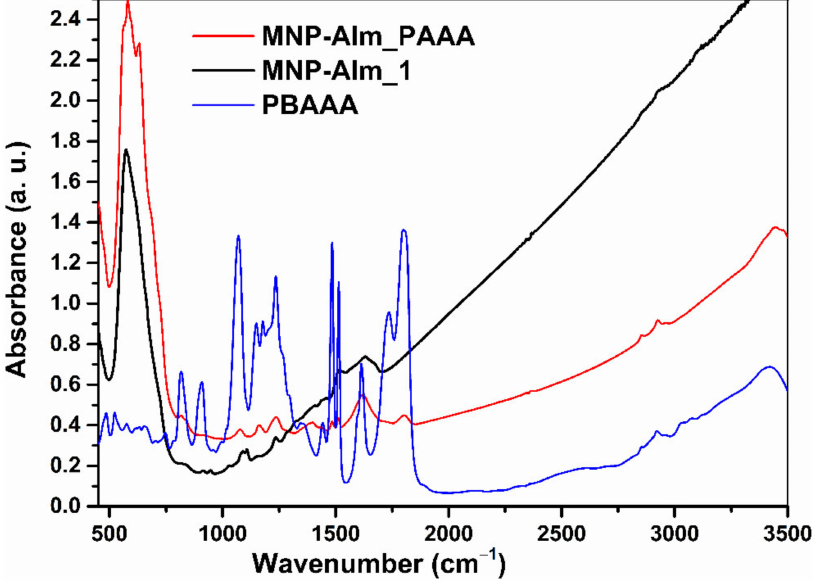
Figure 2. FTIR spectra of functionalized magnetic nanoparticles MNP-AIm_1, polymer PBAAA and magnetic nanostructure